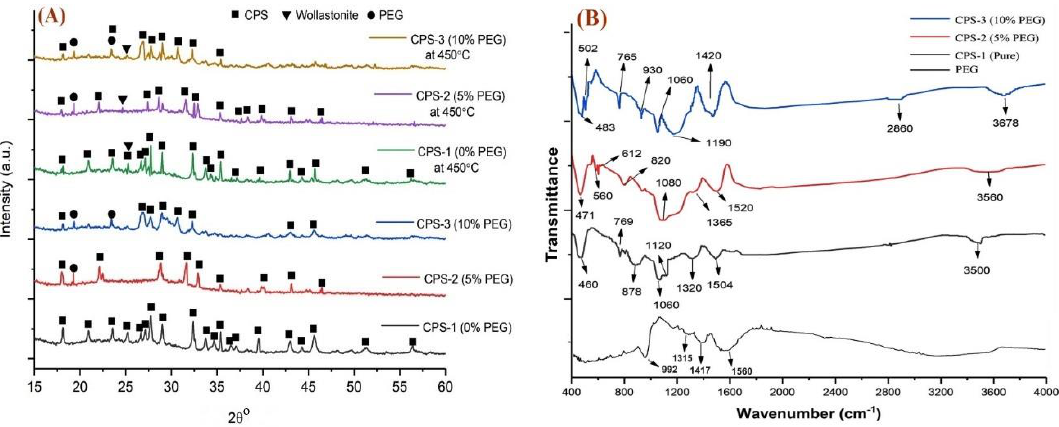
Figure 2. Typical ( A ) XRD pattern and ( B ) FTIR spectra of porous calcium phosphate silicate. FTIR (Figure 2B) spectrum data revealed O–H stretching vibrations observed at 3500, 3560